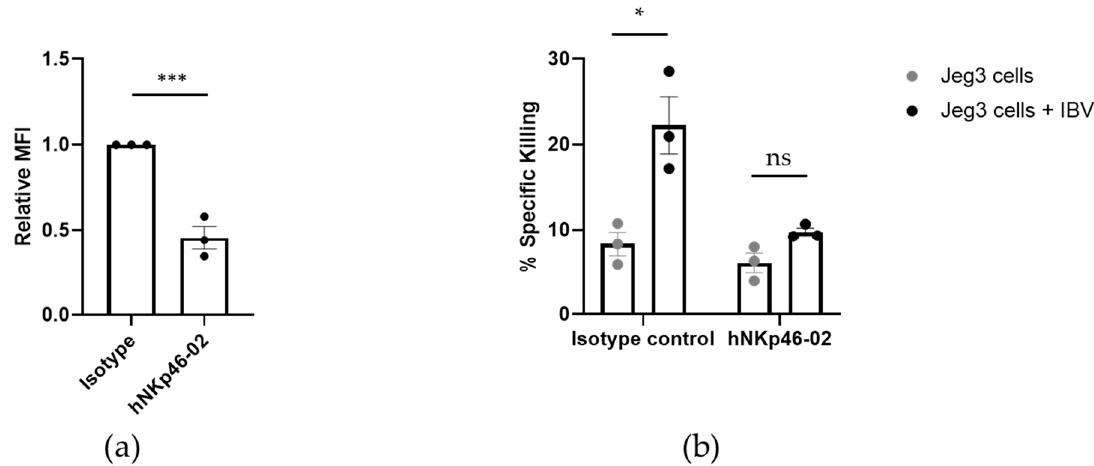
Figure 4. When expression of NKp46 is reduced from the cell surface, NK cells are not able to effectively kill IBV. NK cells were incubated with hNKp46.02 internalizing antibody for 16 h at 37 ◦ C. ( a ) Reduction of the expression of NKp46 receptor from the cell surface was verified by FACS staining. The Median Fluorescence Intensity (MFI) of the staining is presented. The graphs summarize average of three independent experiments. The results were normalized to staining of the NK cells incubated with an isotype control. Values are shown as mean ± SEM. *** p < 0.001 by two-tailed paired Student’s t test. ( b ) NK cells treated (shown in ( a )) with an isotype control or with the internalizing hNKp46.02 antibody were incubated with Jeg3 cells in the presence (black dots) or absence (gray dots) of IBV. Killing assays were performed for 5 h. An ANOVA test was performed in order to evaluate significance. Values are shown as mean ± SEM. * p < 0.05. Figure shows cumulative results of three independent experiments.